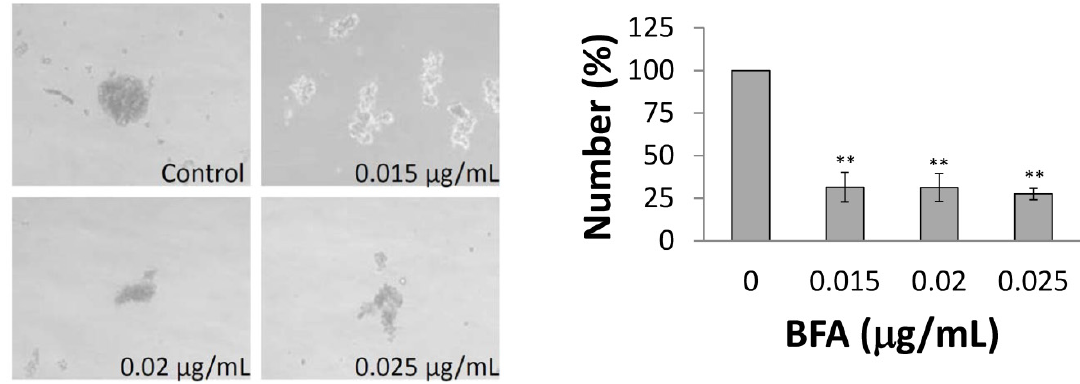
Figure 2. The effect of BFA on the number of Colo 205 tumorspheres. Colo 205 cells (1000 cells /well) were grown in ultra-low attachment 96 wells in the presence of 0.012 to 0.025 µg/mL BFA for two weeks. The images of tumorspheres were captured under phase contrast microscopy. ImageJ was used to determine the number of tumorspheres with diameters larger than 50 µm. Representative results from three independent experiments are presented. (mean ± SD, n = 3; **, p < 0.01).